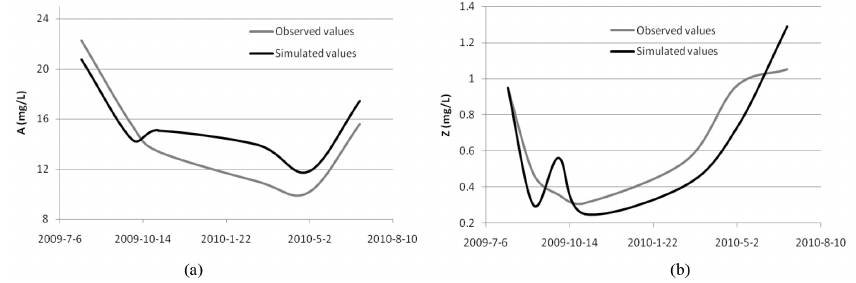
Figure 17. Validation results for phytoplankton biomass (a) and zooplankton biomass (b) at site 10.